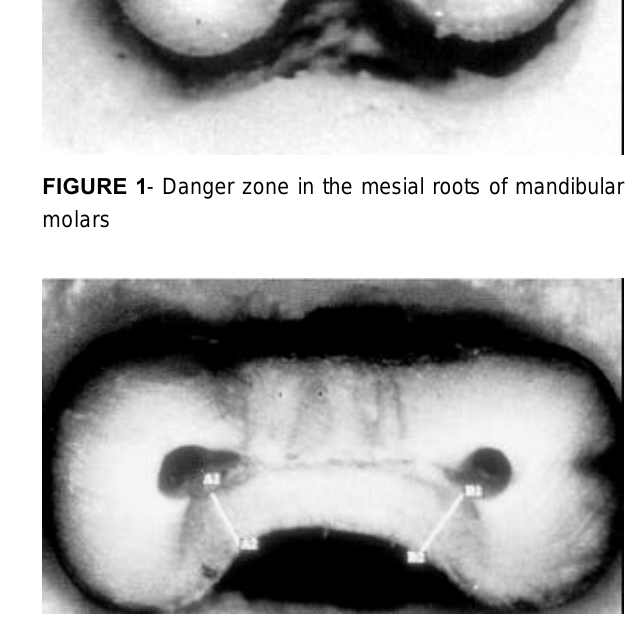
FIGURE 2 - Reference points to measure the danger zone of each mesial canal